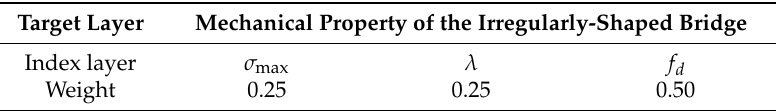
Table 4. Hierarchical structure and index